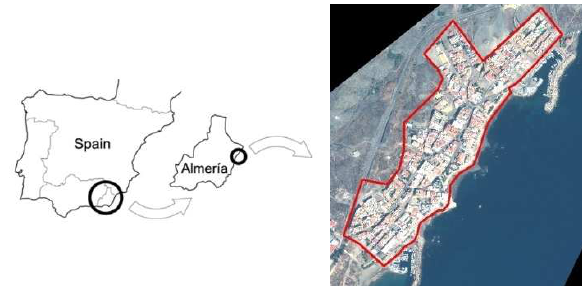
SAVI index, and nDSM.